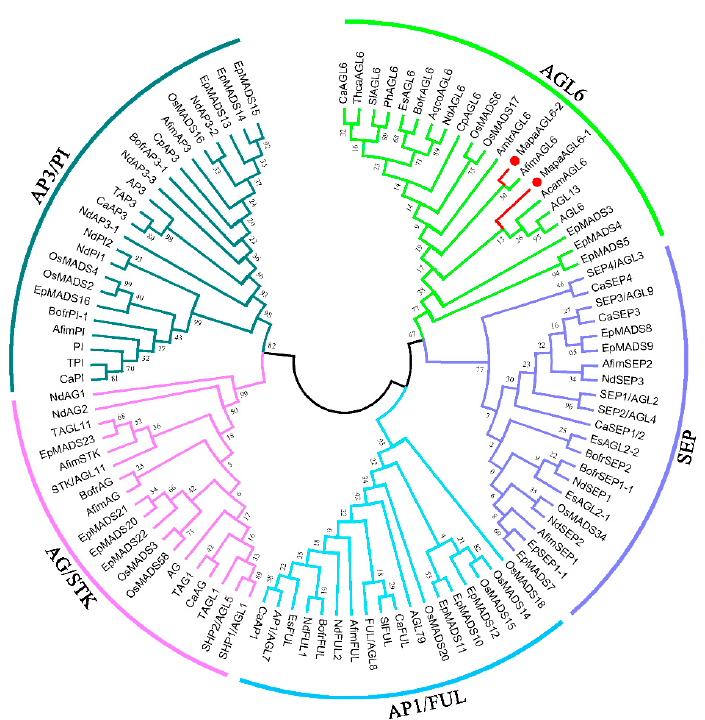
Figure 2. Phylogenetic analysis of MADS-box proteins. The tree was constructed with MEGA5.0 software using the maximum likelihood method. Numbers along the branches are bootstrap values from 1000 replications.